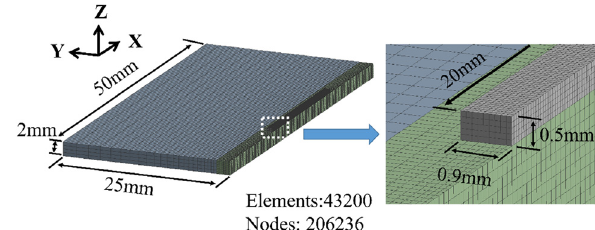
Figure 4: Meshing of fi nite element